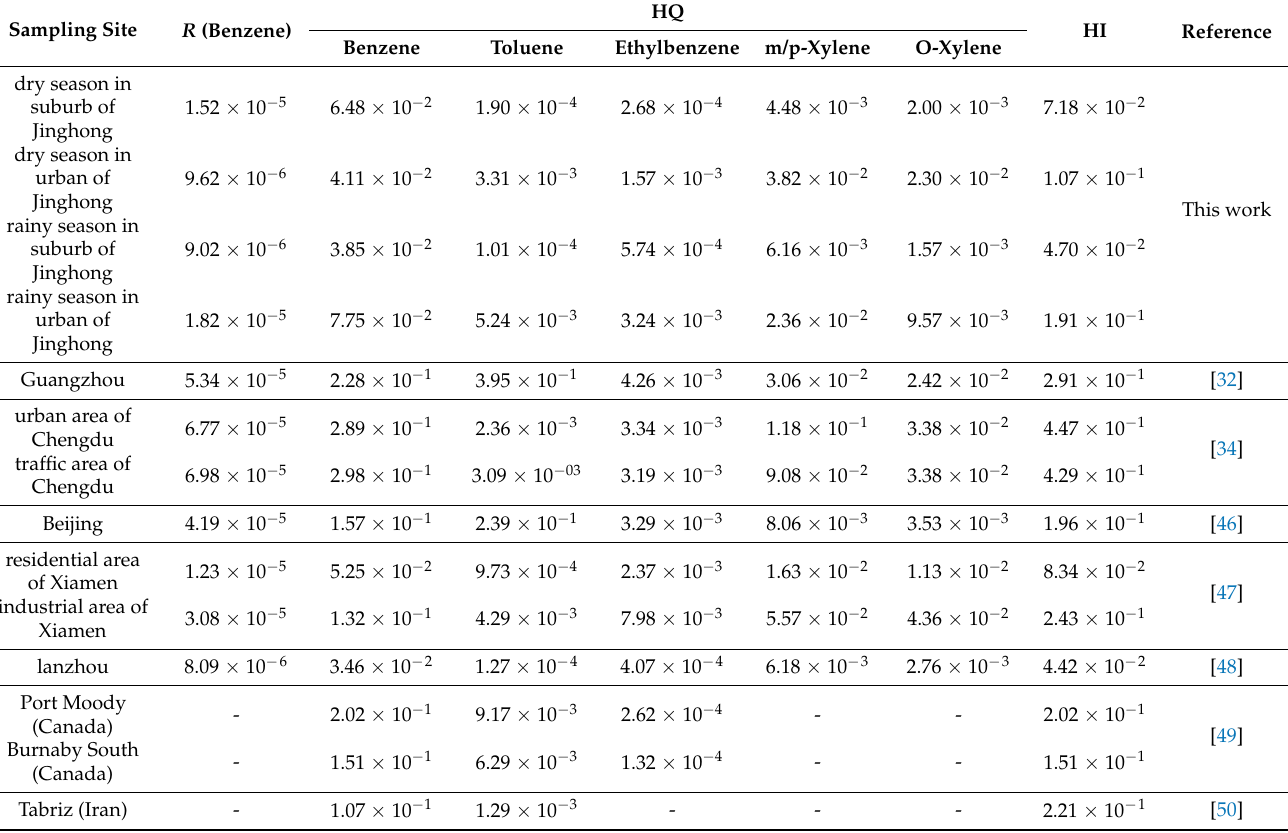
Table 6. Comparison of noncarcinogenic and carcinogenic risks of BTEX in Jinghong with other cities. Sampling